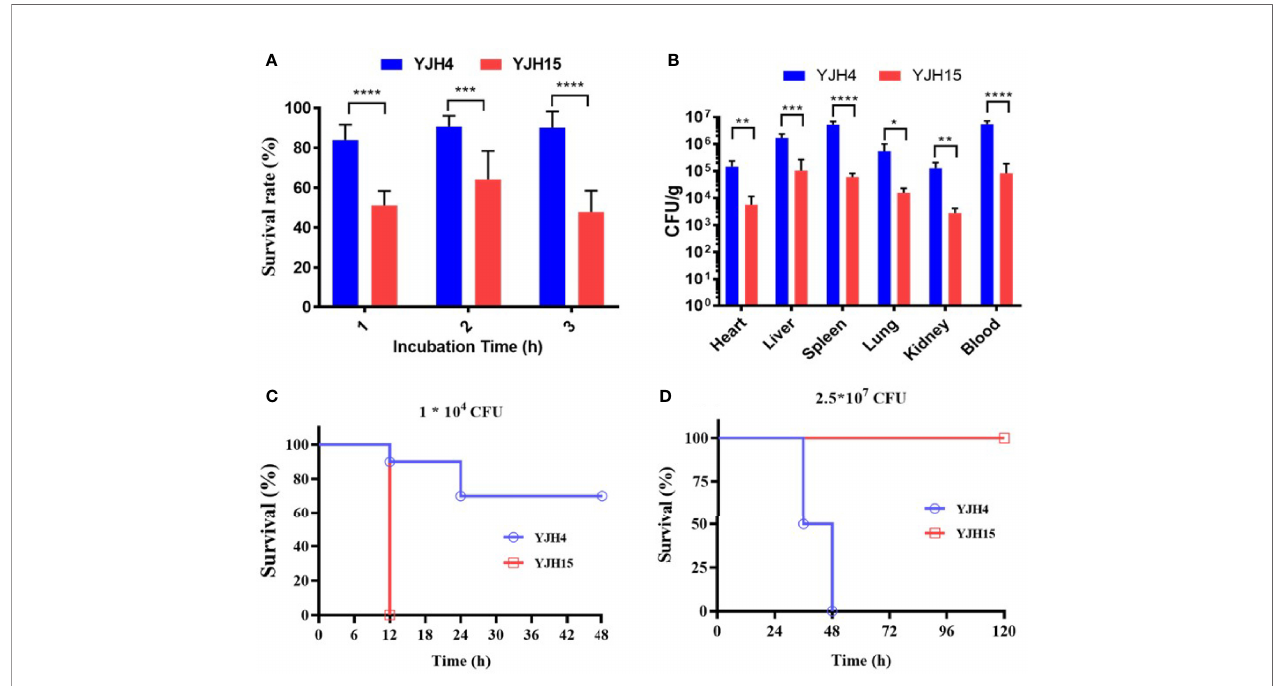
FIGURE 2 | Effect of colistin resistance on K . pneumoniae virulence expression. (A) HL-60 cell killing assay. The survival rate was depicted as the percentage of K . pneumoniae strain that survived treatment with the dHL-60 cells. (***P < 0.001, ****P < 0.0001). (B) In vivo competition in mouse infection model. ICR mice were infected with a mixture of equal proportion of strain YJH4 and YJH15 (1*10 6 CFU mixed at a ratio of 1:1). Bacterial loads of K . pneumoniae YJH4 and YJH15 in blood, heart, liver, spleen, lung and kidney homogenates of mice at 24hrs post-infection were determined. Data were presented as the mean of CFU g -1 ± SD and analyzed by unpaired t test. *~****, ( P < 0.05 ~ P < 0.0001). (C) Virulence potential of colistin-resistant and colistin-susceptible K . pneumoniae in G . mellonella infection model. The percentage survival of G mellonella infected with 1*10 4 CFU (**** P < 0.0001) of each K . pneumoniae strain at 48hrs is shown (n = 10). (D) Virulence potential of colistin-susceptible YJH4 and colistin-resistant YJH15 in mouse infection model. The percentage survival of ICR mice infected with 2.5*10 7 CFU of each K . pneumoniae strain at 120hrs is shown (** P = 0.0084). Ten mice were infected in each group. Statistical analysis of animal survival curves was conducted by performing the Log-rank (Mantel-Cox)